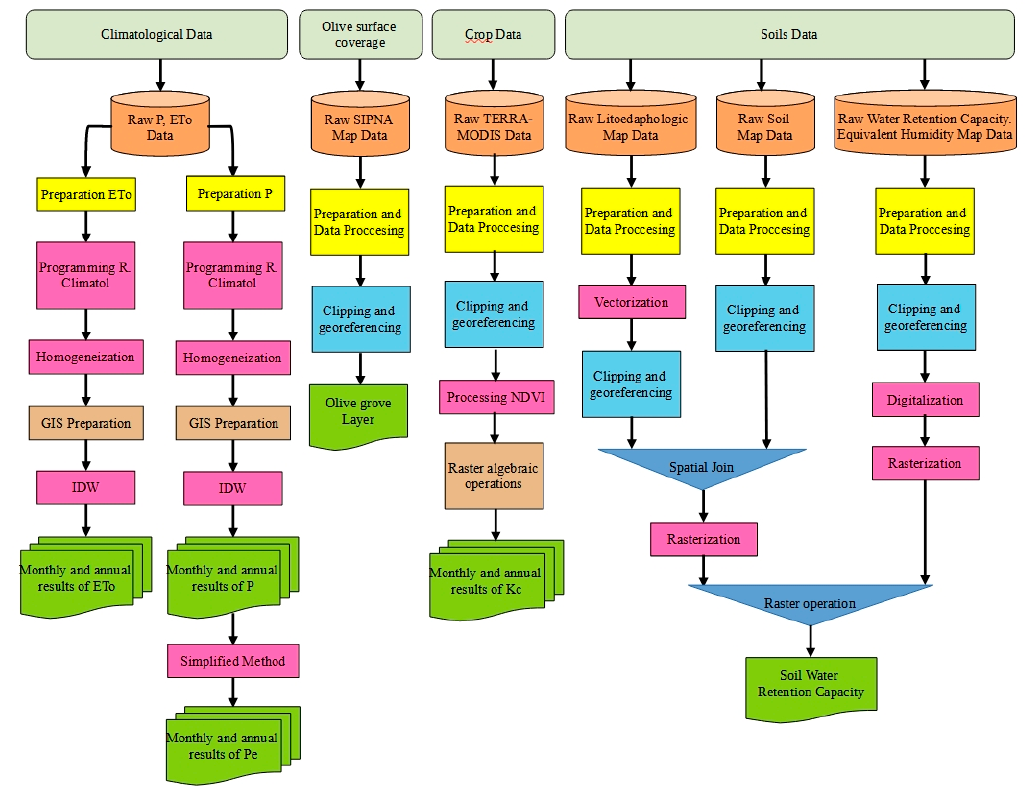
Figure 2. Detailed flow diagram of the methodology, (GIS is geographic information systems; IDW is inverse distance interpolation; SIPNA and TERRA-MODIS are described in Section 2.2; climatological data P and ETo are described in Section 2.3; NDVI and Kc are described in Section 2.4; soil data are described in Section 2.5).